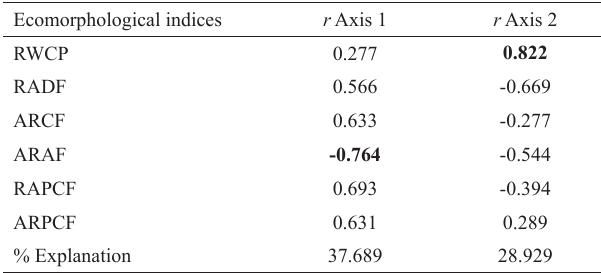
of the ecomorphological indices were based on hypotheses and remain to be tested. Table 3. Pearson correlation coefficients ( r ) obtained for the first two axes of the Principal Components Analysis (PCA) for six ecomorphological indices related to locomotion in the 19 species analyzed. The indices with the highest cor - relation coefficients (shown in bold type) were selected for interpretation. Codes: Relative width of the caudal peduncle (RWCP); Relative area of the dorsal fin (RADF); Aspect ratio of the caudal fin (ARCF); Aspect ratio of the anal fin (ARAF); Relative area of the pectoral fin (RAPCF); Aspect ratio of the pectoral fin